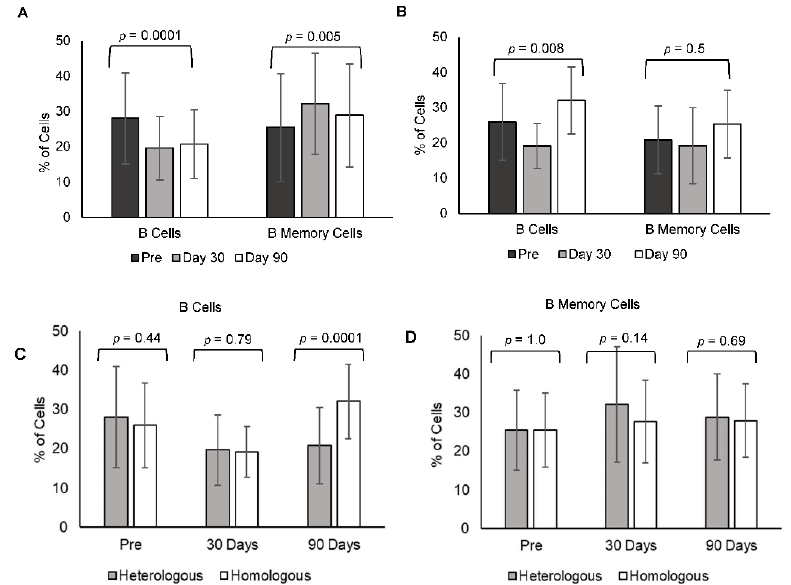
Figure 3. B memory cells heterologous vs. homologous booster dose: humoral immune response in individuals receiving heterologous and homologous booster vaccines. Comparison of ( A ) B lymphocytes (CD20+) and ( B ) B memory (CD20+CD27+) cells at pre, day 30, and day 90 samples of individuals receiving heterologous and homologous booster vaccine p values were compared in between the groups. Within group analysis of B cells and B memory cells in ( C ) heterologous and ( D ) homologous booster doses p values were shown together for pre, day 30 and day 90. Vaccines 2022 , 10 , x FOR PEER REVIEW 3.7. Heterologous Booster Dose Elicits RBD-Specific B Non-Memory (Antibody-Secreting) and B Memory Cells Heterologous booster increased RBD-specific B memory cells (CD27+) and B non- memory cells (antibody-secreting B lymphocytes CD27 − ) at day 30 (RBD+CD27+:12.67 ± 13.55, RBD+CD27: 29.5 ± 30.8) and day 90 in comparison to pre-booster levels